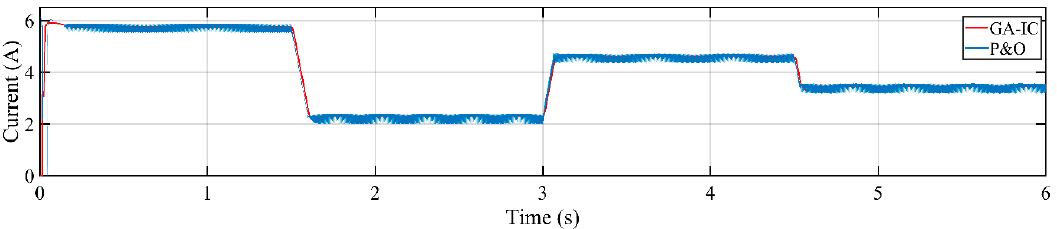
Figure 20. Case 1 current comparison of modified GA-IC vs. P&O.